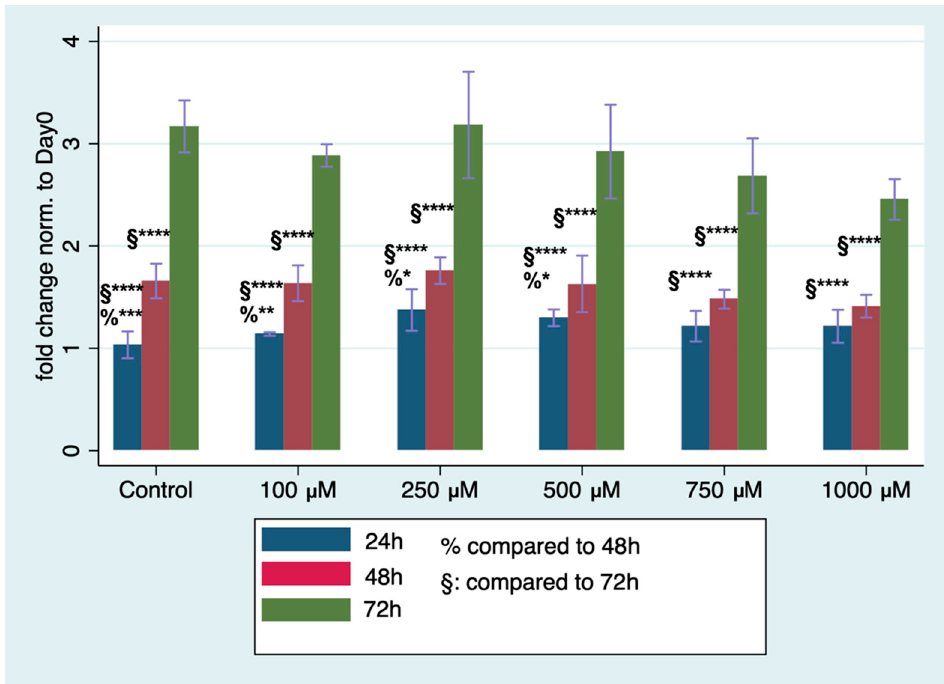
Figure 1. Relative viable cell count of human nucleus pulposus (NP) cells after 24, 48, and 72 h of losartan exposure. Means + standard deviations are shown. Data from two donors assessed in triplicate are shown ( n = 6). %: compared to 48 h of exposure; §: compared to 72 h of exposure; * p < 0.05; ** p < 0.01; *** p < 0.001; **** p < 0.0001.